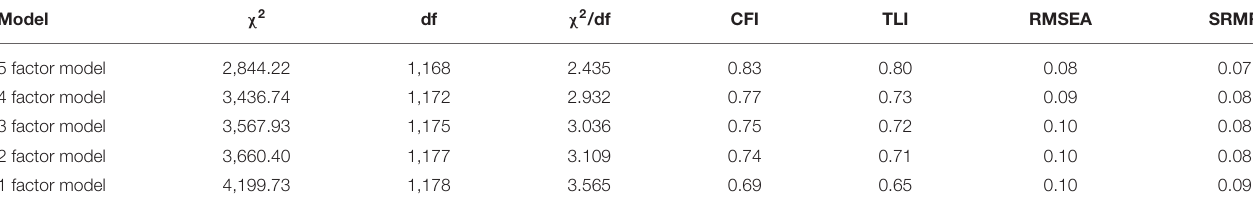
TABLE 1 | Comparison of the goodness-of-fit indices of alternative models. Model χ 2 df χ 2 /df CFI TLI RMSEA SRMR